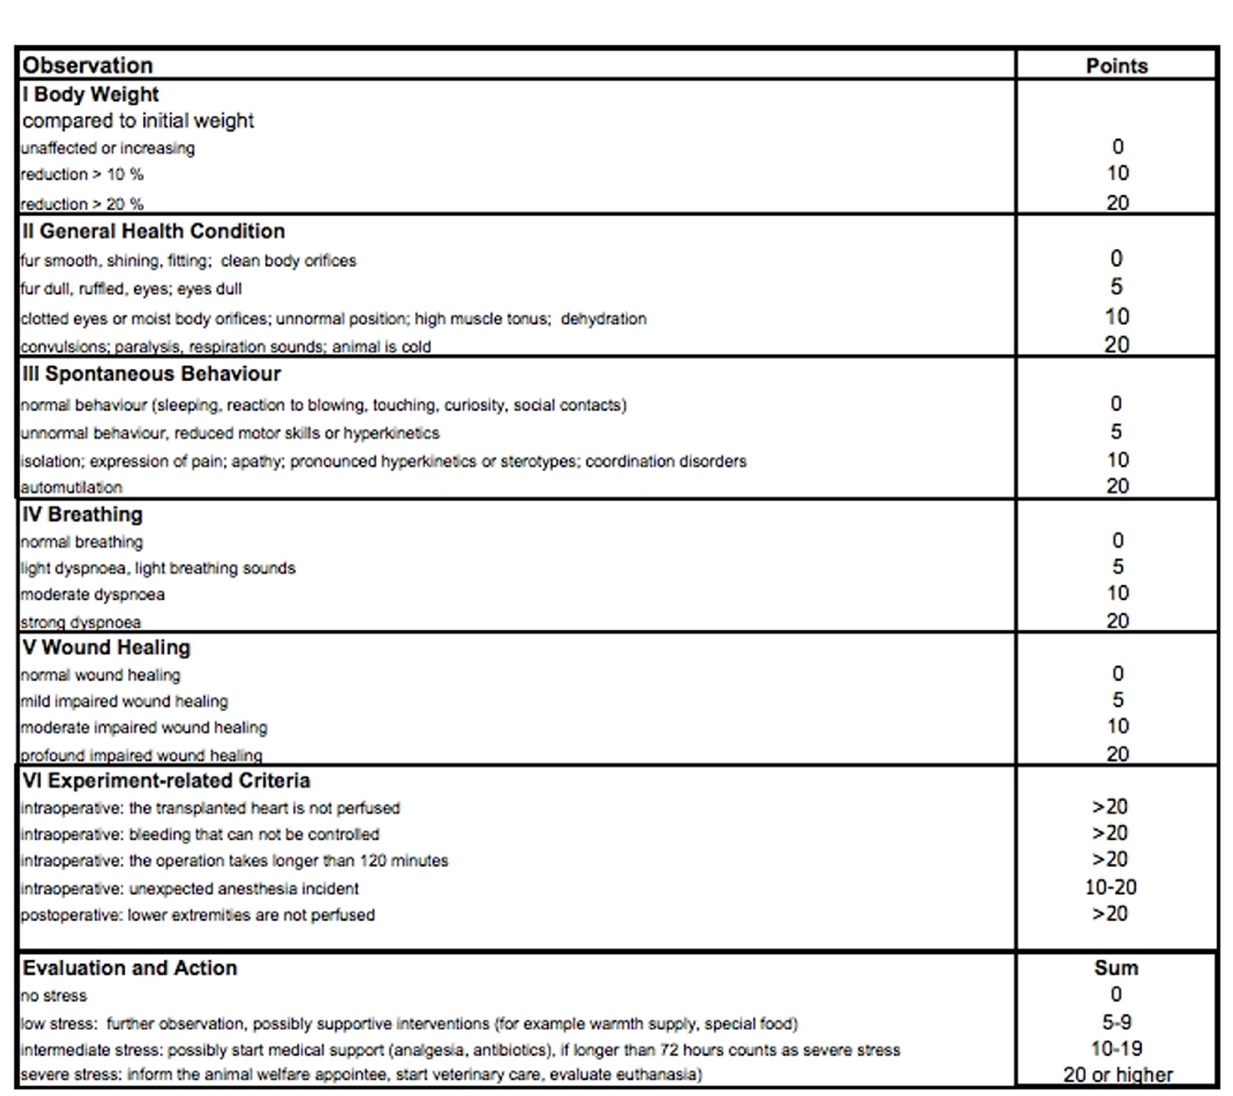
Fig 8. Scoring sheet used for daily postoperative evaluation of the recipient animal. Five categories were used to score the animals postoperatively. For each category points were assigned, that were summed up in a total score to evaluate if further action was required.